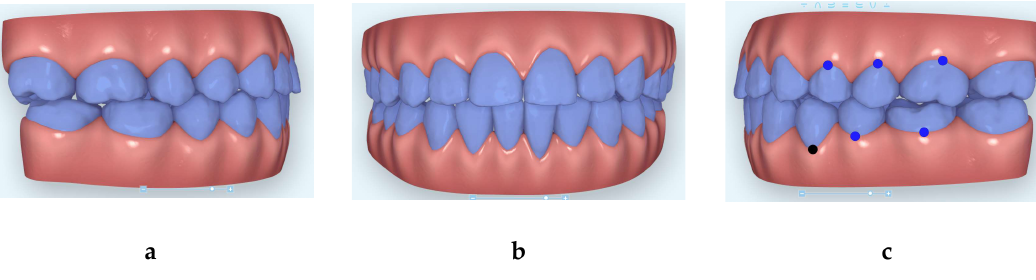
a Figure 6. Images of the beginning of third Clincheck ( a ): right side; ( b ) frontal view and ( c ) left side. Figure 6. Images of the beginning of third Clincheck ( a ): right side; ( b ) frontal view and ( c ) left side . Figure 6. Images of the beginning of third Clincheck ( a ): right side; ( b ) frontal view and ( c ) left side . Figure 6. Images of the beginning of third Clincheck ( a ): right side; ( b ) frontal view and ( c ) left side . Figure 6. Images of the beginning of third Clincheck ( a ): right side; ( b ) frontal view and ( c ) left side .